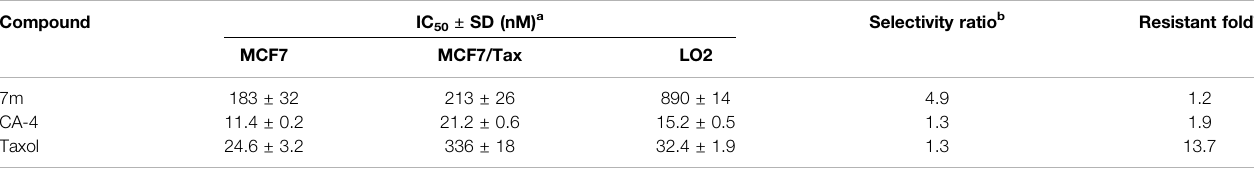
TABLE 3 | Growth inhibitory effects of 7m on LO2 and MCF7/Tax cells. Compound